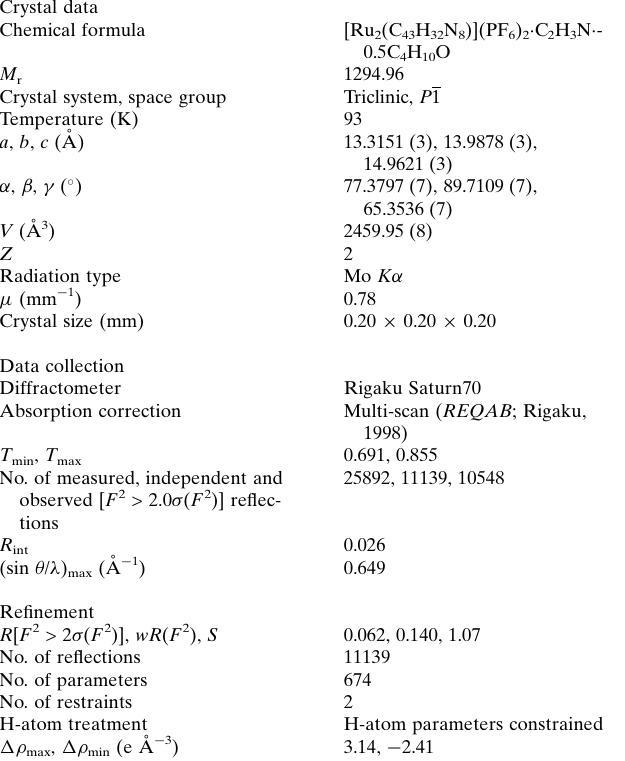
Table 3 Experimental details. Crystal data Chemical formula